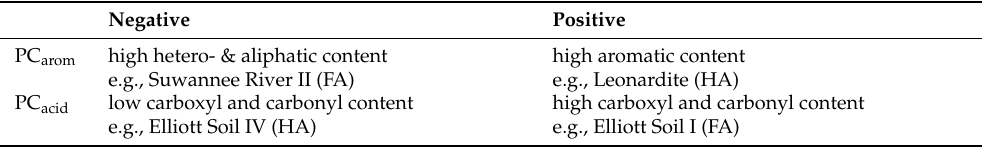
Table 1. Summary of the characteristics of the first two principal components (PC arom and PC acid